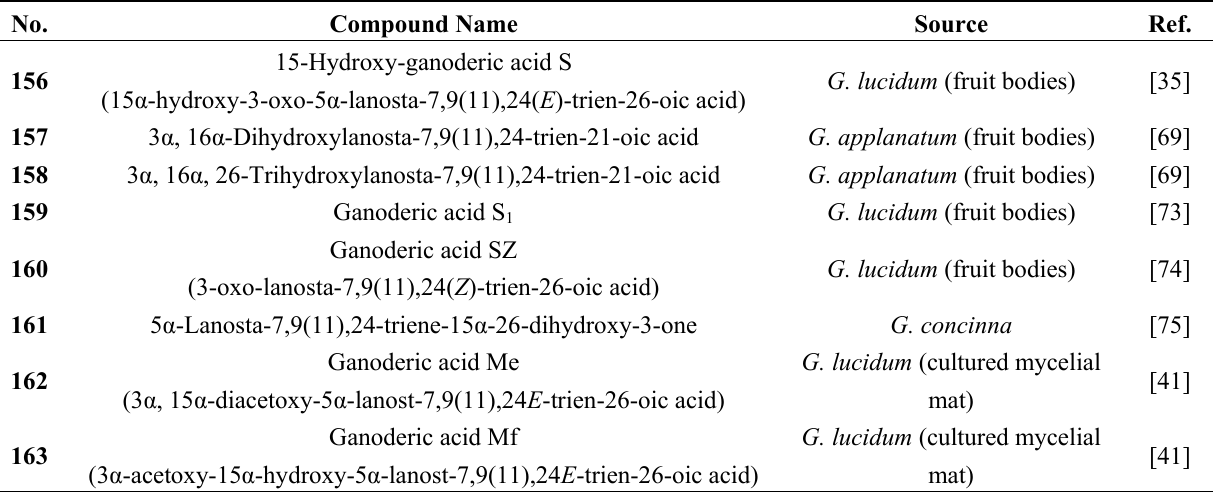
Table 6. Ganoderma triterpenes 156 – 196 in Figure